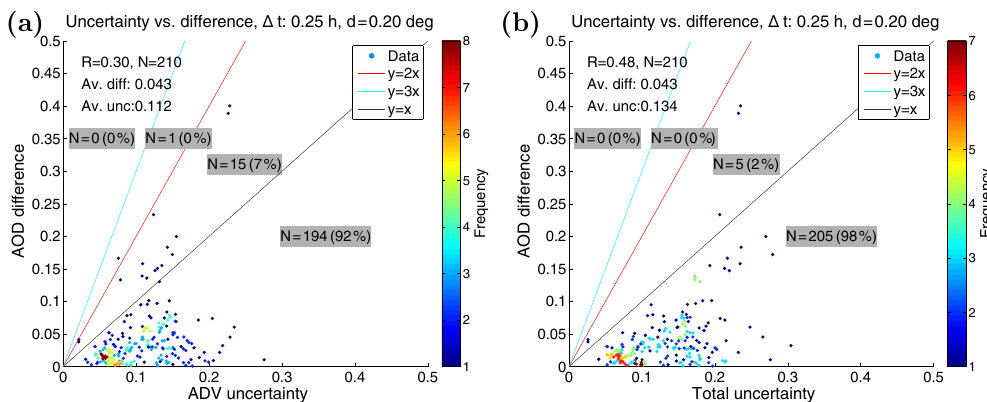
Figure 10. Scatter plot of error vs. uncertainty illustrating Eq. (1). The text inset at top left show the correlation coefficient R between the AOD difference ( | τ AATSR − τ AERO | ) and uncertainty estimate, the number of matches N , and the average difference and average uncertainty. The colored lines correspond to different values of the coverage factor k (see text). The text insets on dark background indicate the number (fraction) of pixels within each “consistency class”. (a) Uncertainty due to ADV AOD uncertainty only. (b) Total uncertainty including collocation mismatch uncertainty